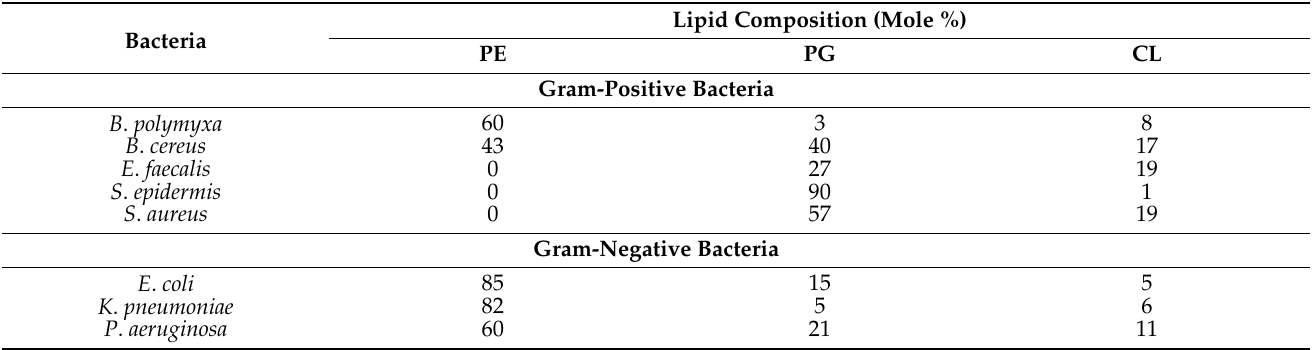
Table 1. Lipid composition of bacterial inner membranes [29]. Copyright Epand et al, Antimicrob Agents Chemother., 2010.